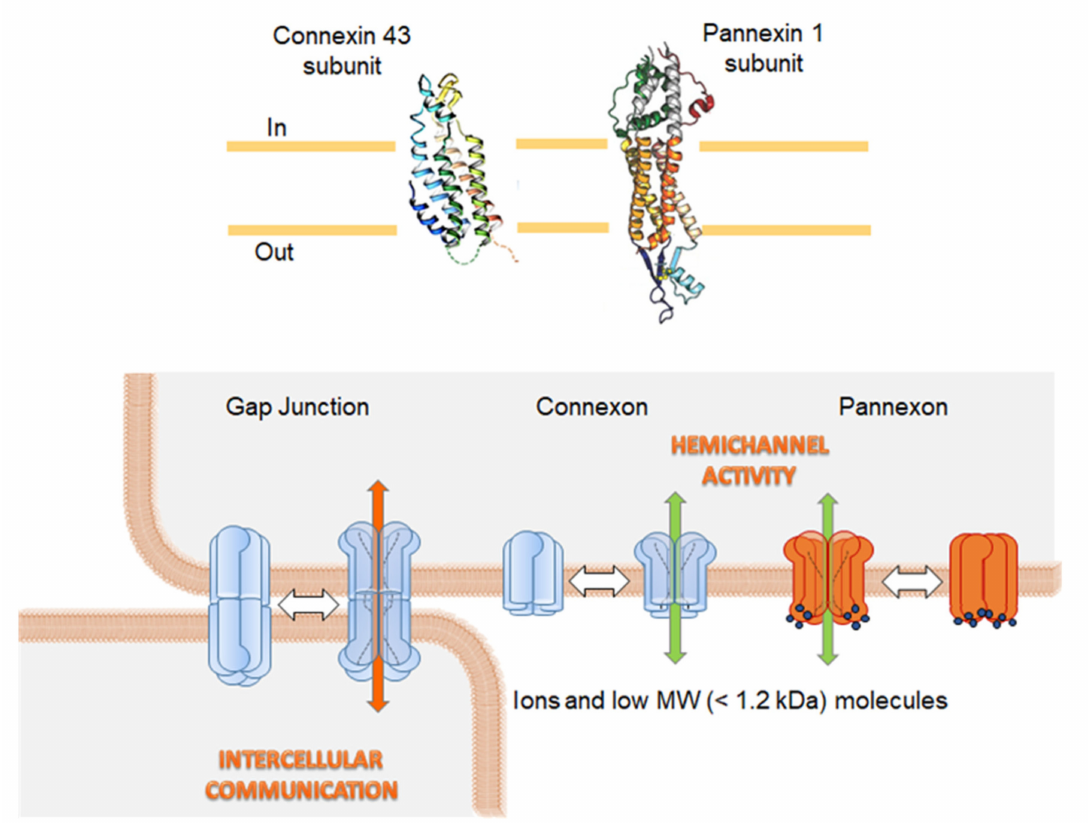
Figure 1. The assembly of connexins and pannexins into hemichannels and gap junctions. The upper panel shows the structure of connexin 43 and pannexin 1 subunits. The lower panel (on the right hand) illustrates how connexins and pannexins assemble into hexamers, called connexon and pannexon, respectively, to form a hemichannel. Docking of two hemichannels from two neighboring cells form a gap junction (on the left hand). They permit the cells to exchange ions and small low molecular weight (MW) molecules with <1.2 kDa, that is intercellular communication. The shown protein structures of connexin 43 and pannexin 1 were taken from the RCSB-protein data bank (http://www.rcsb.org/ access date: 31 January